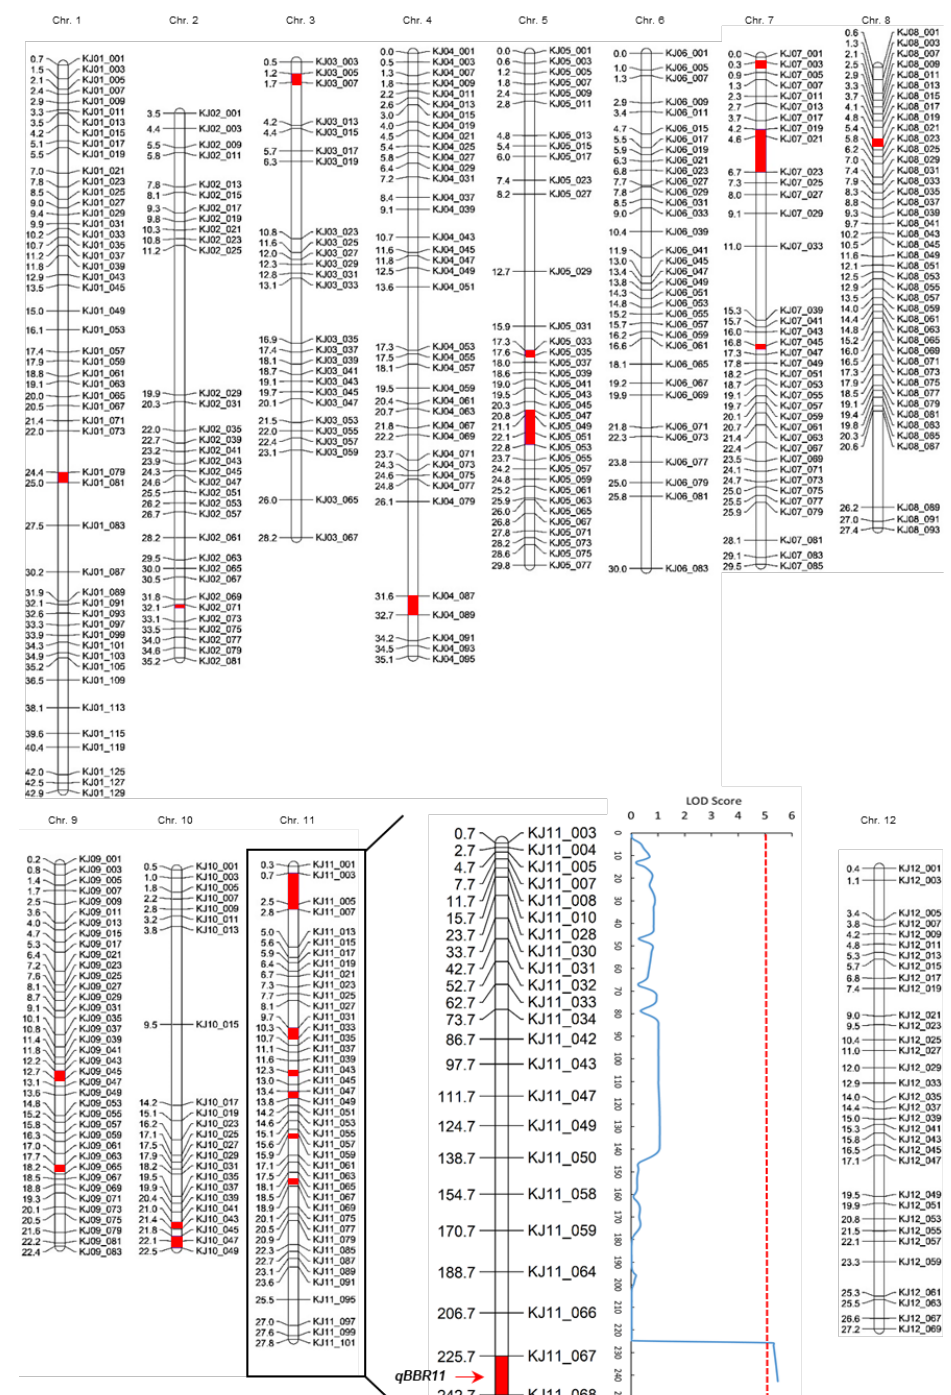
Figure 2. Genetic linkage map constructed based on the KASP marker. ( a ) Distribution of polymor- phic KASP markers of JJ623 and HR27195 on 12 rice chromosomes. Among the 888 KASP markers, polymorphisms of JJ623 and HR27195 were analyzed in the remaining chromosomes except for chromosome 12, and these regions are marked in red. ( b ) LOD contour of the QTL mapped region using lesion length by Xoo . An LOD score of 5.47 was detected at 17.0 cM of KJ11_067 to KJ11_068, showing the region of the corresponding chromosome. The KASP marker name is shown on the right side of the chromosome, and the number on the left shows the genetic distance of the markers in centimorgans (cM).